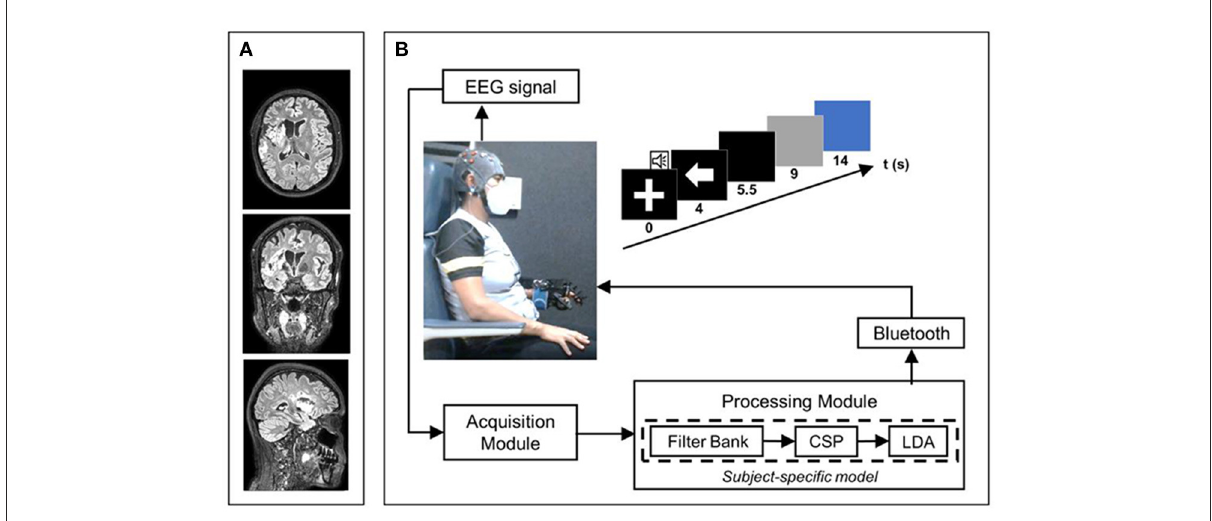
FIGURE2 Stroke imaging and depiction of the BCI system. (A) Patient’s T2 FLAIR MRI sequences were obtained with a 3T Philips Ingenia device at the onset of the BCI intervention. (B) BCI system stages and its associated trial timing